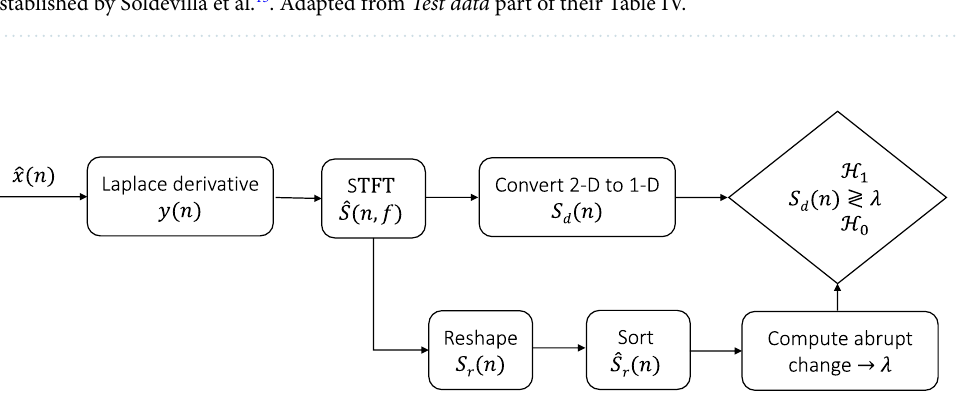
Figure 4. Block diagram of the proposed detector.